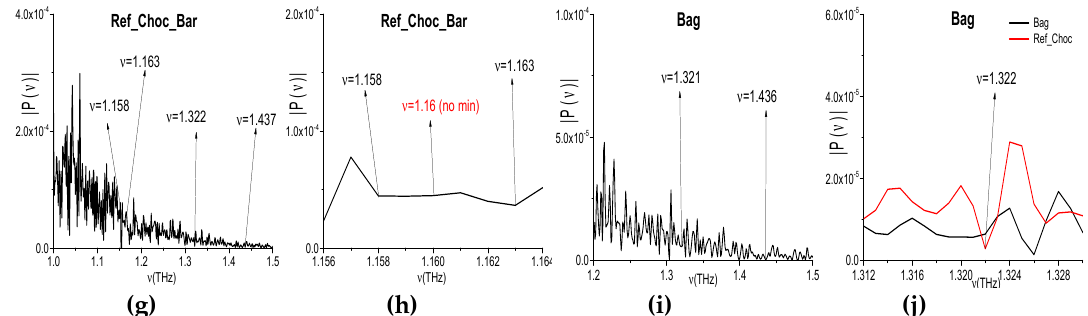
Figure 22 . Spectrum of the Choc_BB signals measured using the broadband THz signal (a,b) in the Figure 22. Spectrum of the Choc_BB signals measured using the broadband THz signal ( a , b ) in the frequency ranges ν = [0, 1.4] THz (a), [1.6, 3.2] THz (b ). Spectra of the Choc_Bar_AVG signals (c,d) frequency ranges ν = [0, 1.4] THz ( a ), [1.6, 3.2] THz ( b ). Spectra of the Choc_Bar_AVG signals ( c , d ) and and Choc_Bag_AVG signals (e,f) measured using the narrowband THz signal in the frequency ranges Choc_Bag_AVG signals ( e , f ) measured using the narrowband THz signal in the frequency ranges ν = ν = [1.0, 1.5] THz (c,e) and [1.156, 1.164] THz (d,f). Reference spectrum (g,h) in the same frequency [1.0, 1.5] THz ( c , e ) and [1.156, 1.164] THz ( d , f ). Reference spectrum ( g , h ) in the same frequency ranges. ranges. Bag spectrum in the frequency range ν = [1.2, 1.5] THz (i), ν = [1.312, 1.328 THz (j). Bag spectrum in the frequency range ν = [1.2, 1.5] THz ( i ), ν = [1.312, 1.328 THz ( j